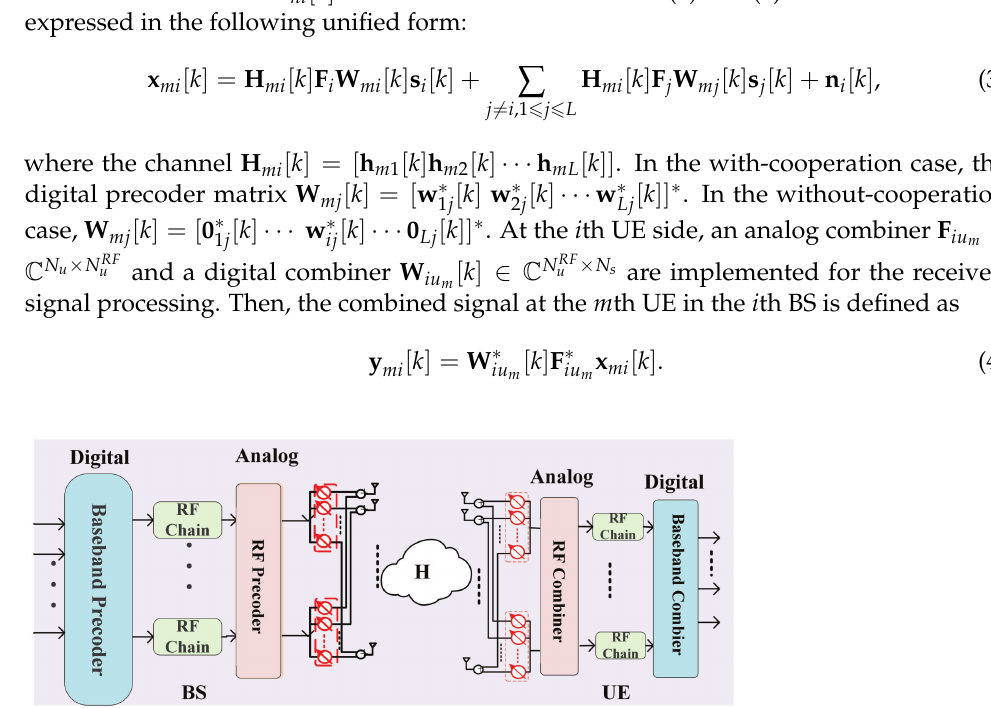
Figure 2. Hybrid analog/digital beamforming